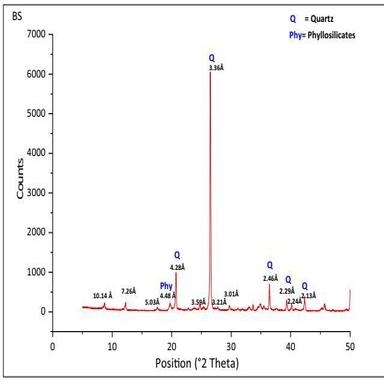
X-Rays diffraction of the three bulk samples: EB. BM and BS.